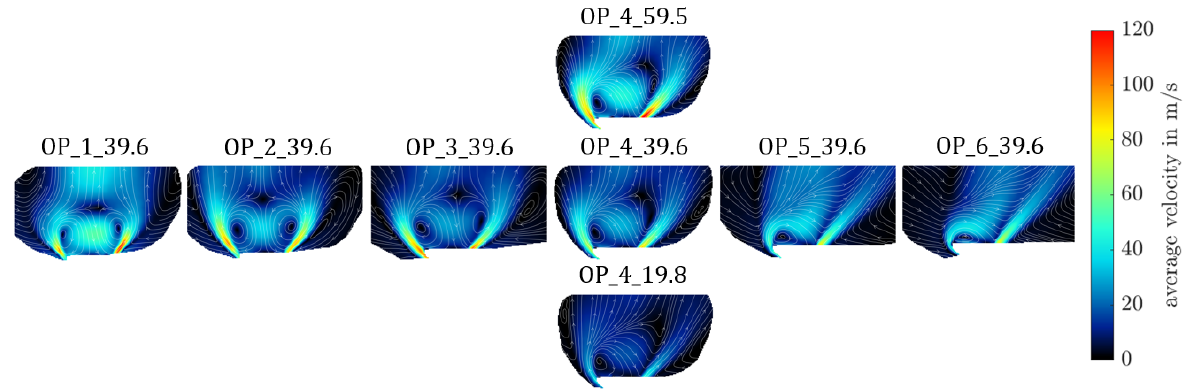
Figure 9. Ensemble of average measured velocity fields (colour bar) and streamlines (white arrows) for different valve lifts and mass flow rates; nomenclature: OP_4_39.6 = 4 mm valve lift, 39.6 kg/h mass flow.